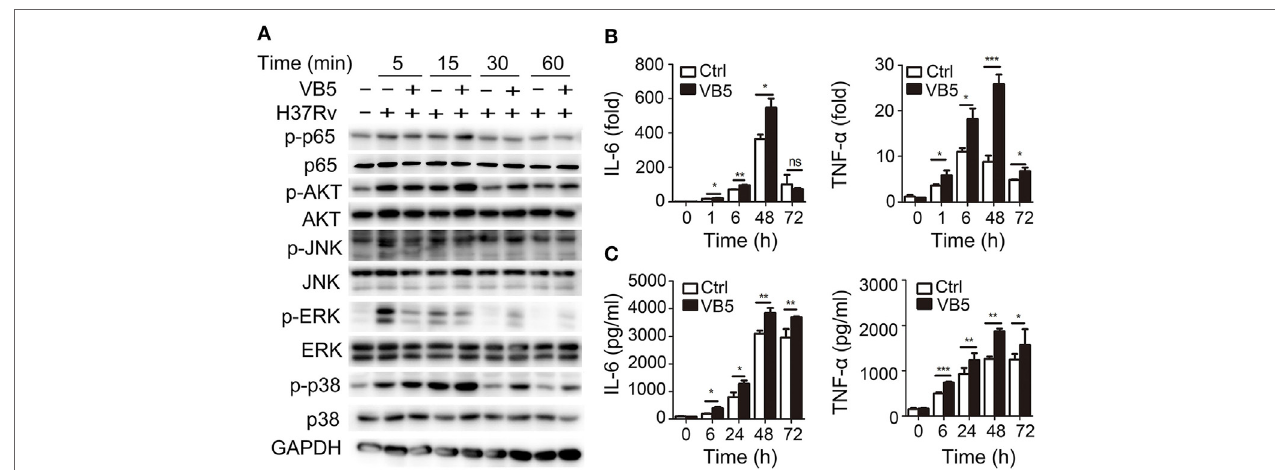
FigUre 2 | Vitamin B5 (VB5) promoted the innate immune response in macrophages after mycobacterial infection. Bone marrow-derived macrophages were pretreated with VB5 followed by Mycobacterium tuberculosis H37Rv infection. (a) Western blot analysis of the phosphorylation status of NF- κ B, AKT, JNK, ERK, and P38. GAPDH is as an internal control. These results are from a representative experiment ( n = 3). (B) Tumor necrosis factor (TNF)- α and interleukin-6 (IL-6) mRNA expression determined by real-time PCR. (c) IL-6 and IL-23 secretion for indicated time points was measured by enzyme-linked immunosorbent assay. * P < 0.05, ** P < 0.01, *** P < 0.001. Data are representative of three independent experiments with similar results.